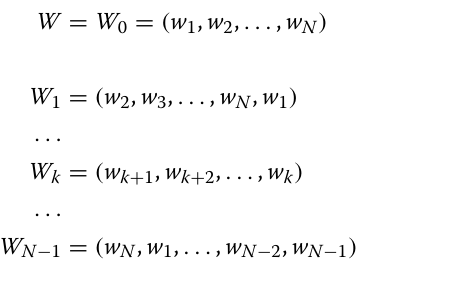
Definition 8 (Cage similarity) Two cages U = . . . , u ) and W = ( w . . . , w ) are similar if ( u N N 1 , u 2 , 1 , w 2 , there exists a similarity function such that f ( u i ) = w i for each i ∈ { 1, 2, . . . , N } . Definition 9 (Shifted cage) A shifted cage of another cage W = ( w 1 , w 2 , . . . , w N ) is a permutation conserving the order of W. There are N shifts (as many as number of